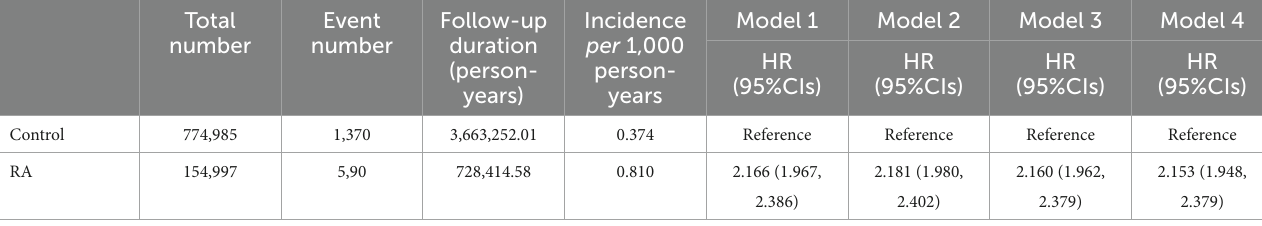
TABLE 2 Cox regression analysis of rheumatoid arthritis (RA) for the risk of end-stage renal disease